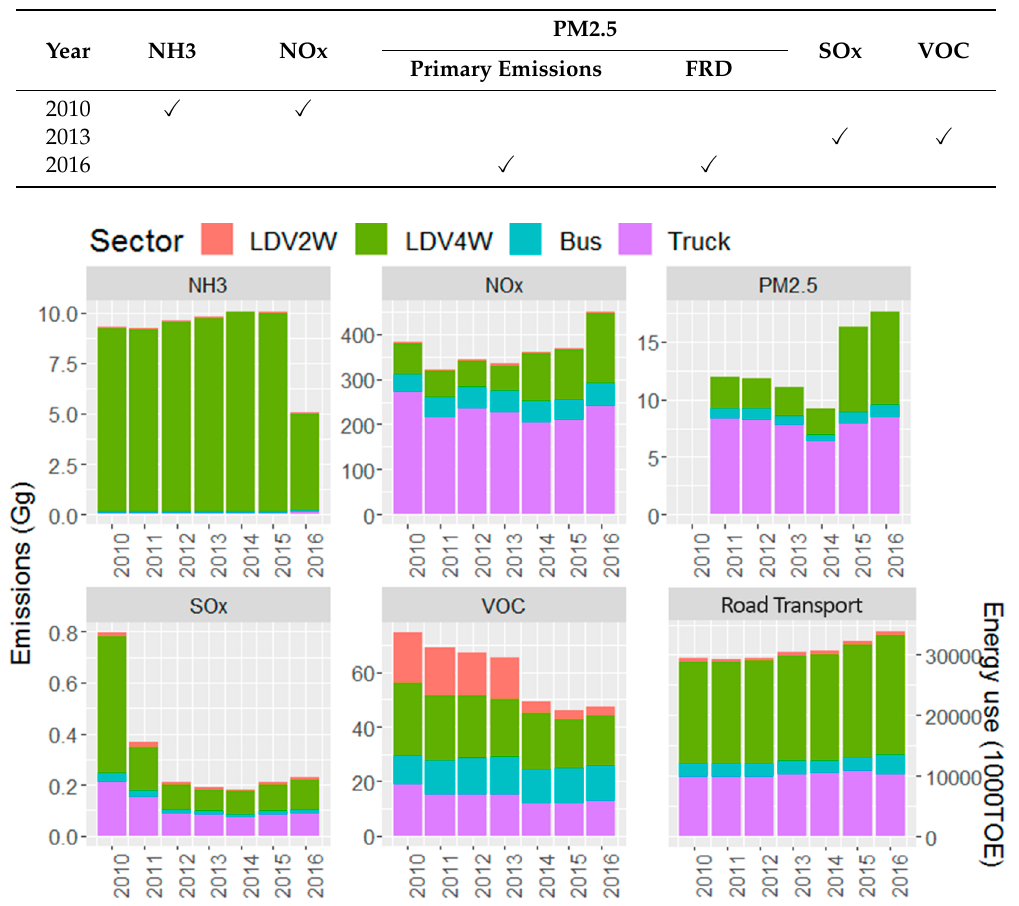
Table 2. Year of air pollutant emissions data used for the calibration.